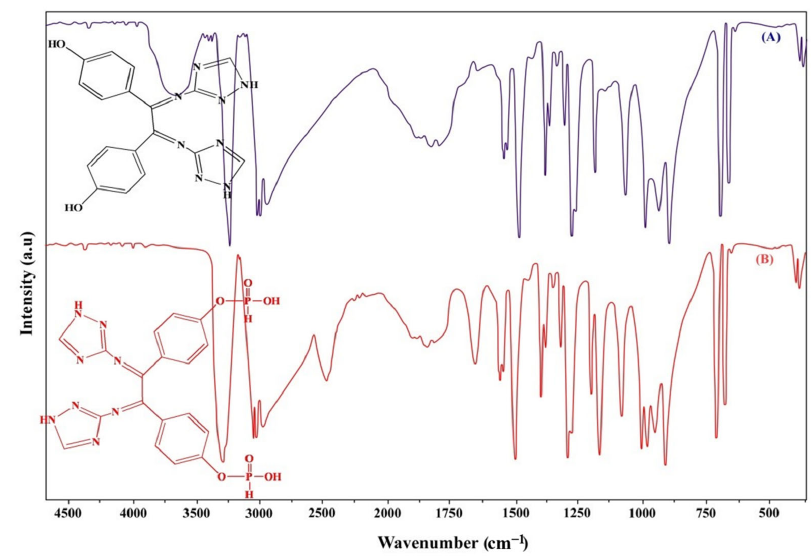
Figure 1. FTIR spectrum of ( A ) TIH, ( B ) TIHP. Table 1. THI and THIP characteristics; surface area and pore size.